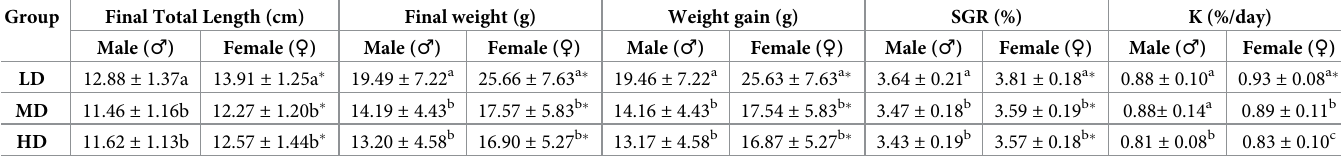
Table 3. Growth performance for male and female of yellow perch reared at different density.